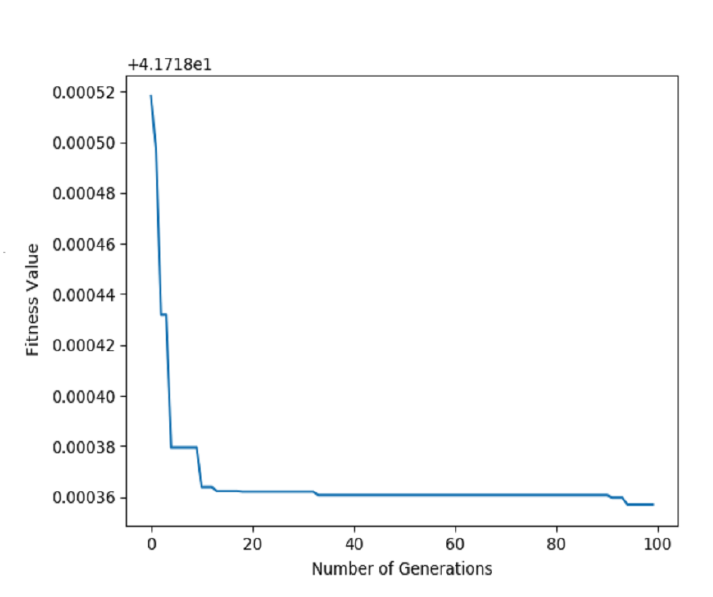
Figure 8. Convergence graph for